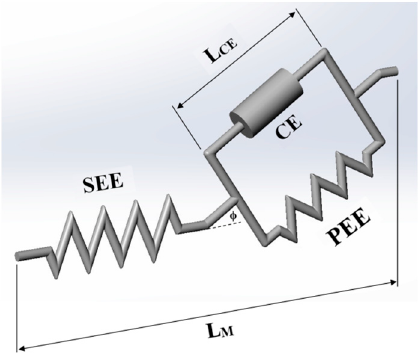
Figure 2. Hill muscle